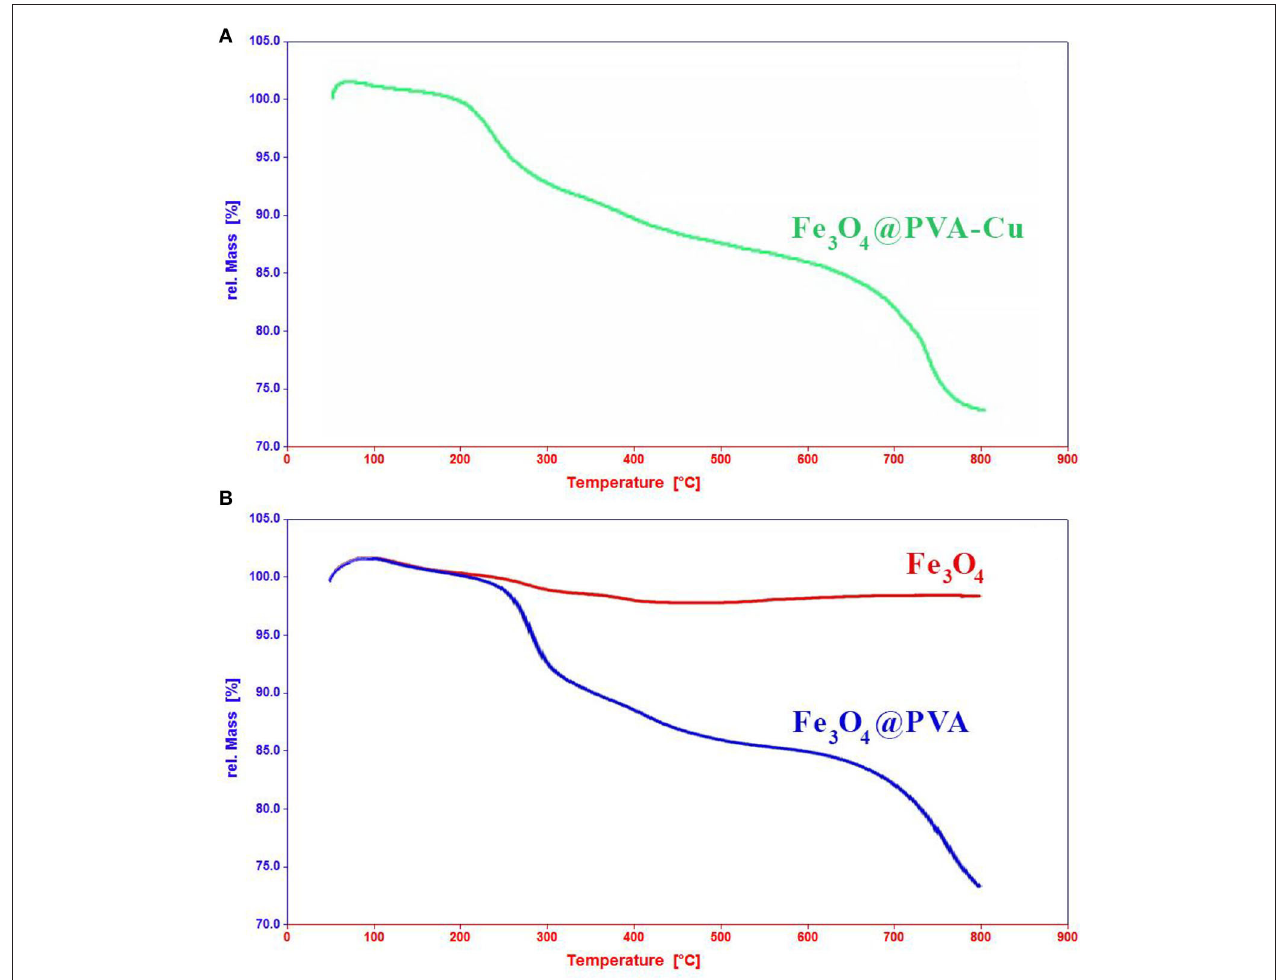
FIGURE 3 | TGA analyses of Fe 3 O 4 @PVA-Cu (A) , Fe 3 O 4 , and Fe 3 O 4 @PVA (B) in temperature ranged from 20 to 800 ◦ C.